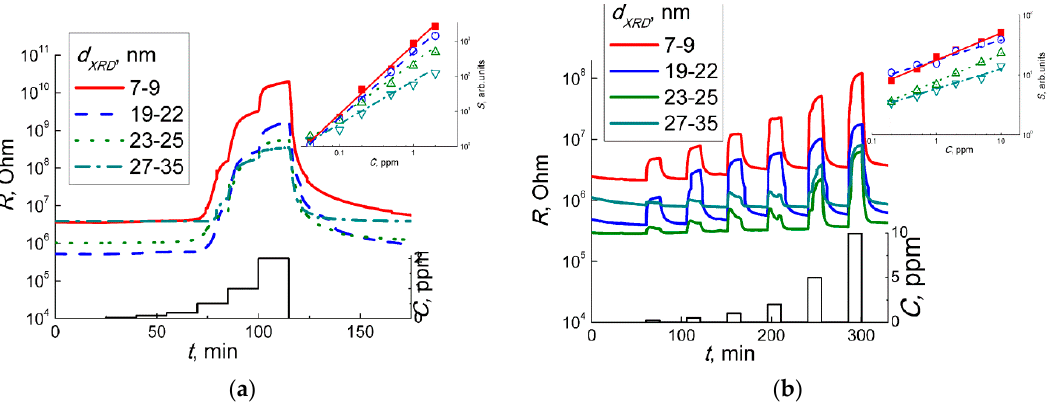
Figure 6. Dynamic responses of WO 3 sensors to 0.04–2.00 ppm of NO 2 in air ( a ) and 0.2–10.0 ppm of NO in air ( b ). Insets show sensor signals as functions of the concentrations of target gases in logarithmic axes.